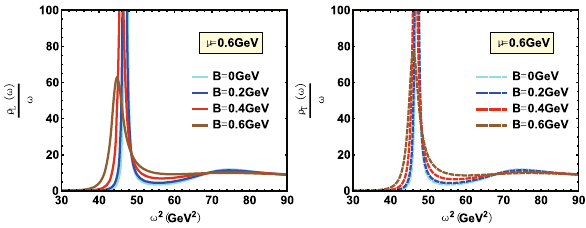
Fig. 7 Thespectralfunctionofthe ϒ( 1 S ) statewithdifferentmagnetic field B at T = 0 . 3GeV. The left picture is for magnetic field parallel to polarization and the right one is for magnetic field perpendicular to polarization